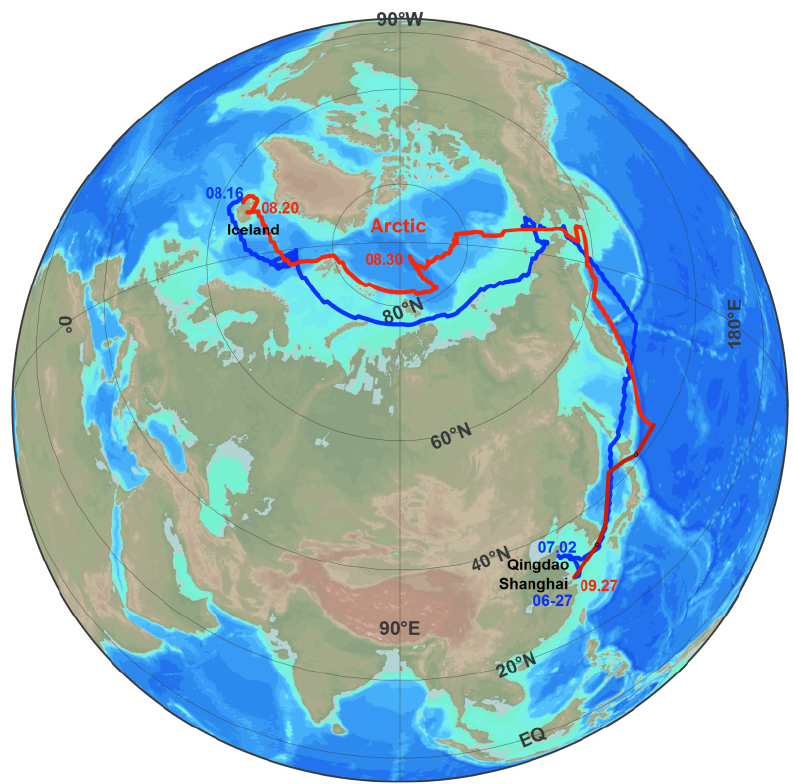
Figure 1. The route of the 5th Chinese Arctic Research Expedition